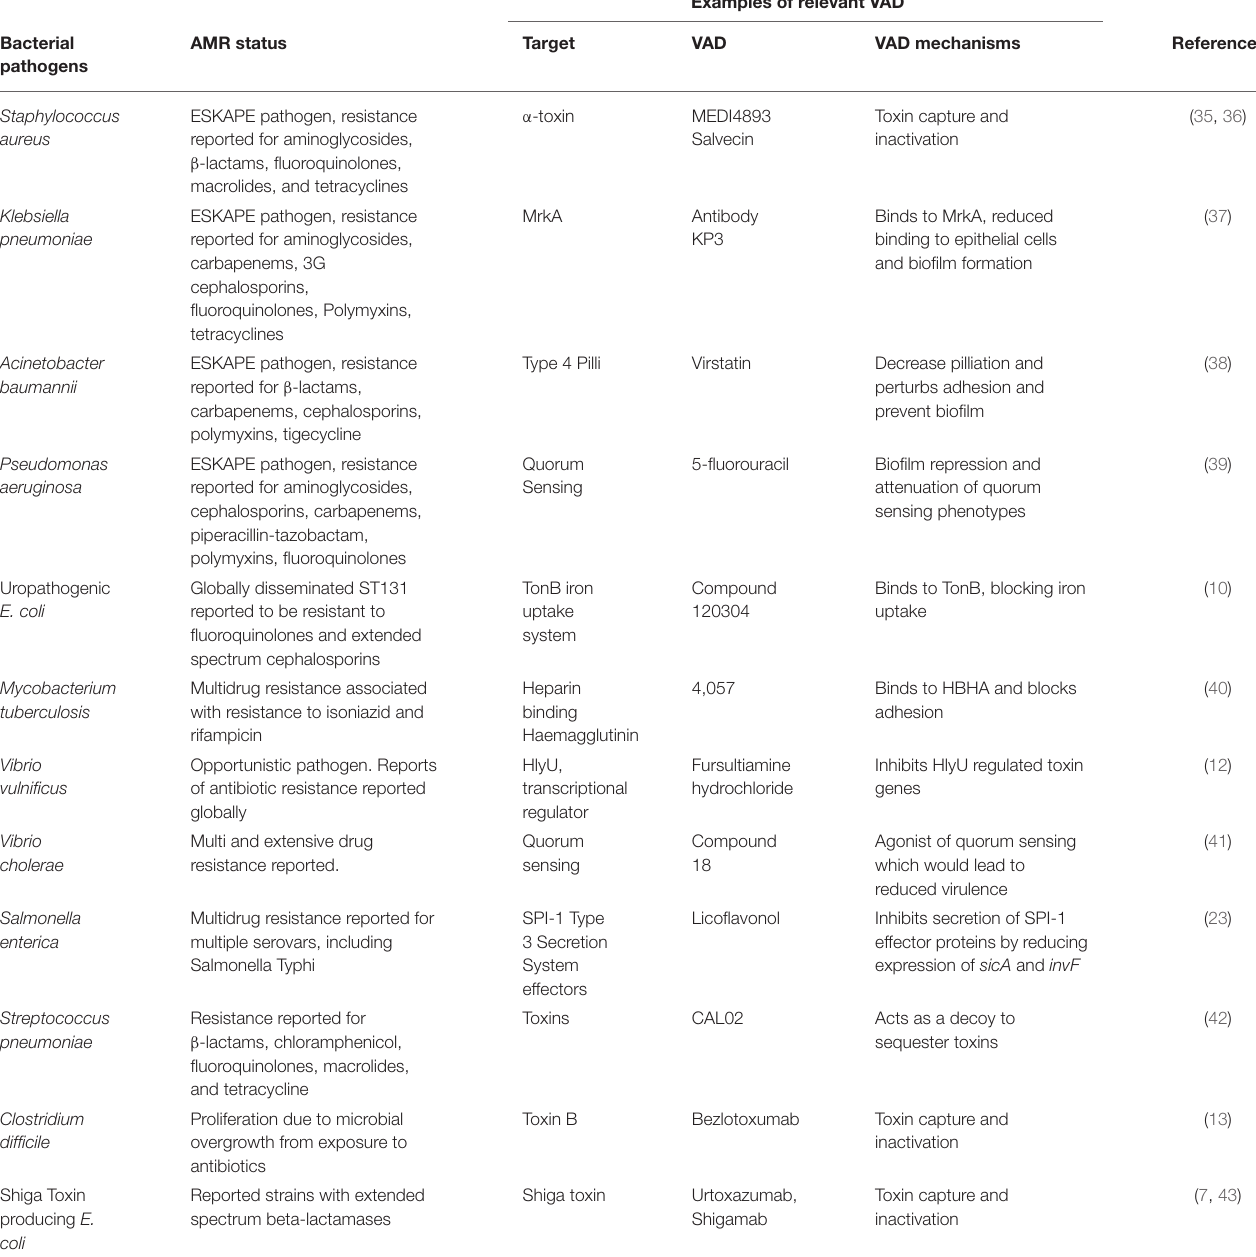
TABLE 1 | VAD candidates for high-burden AMR